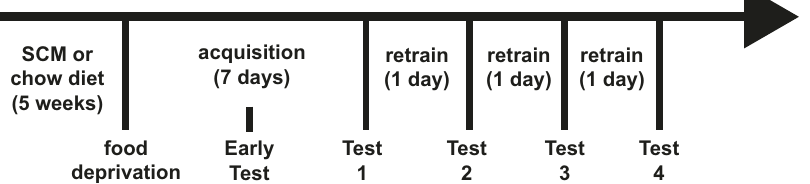
Fig. 1 Timeline for Experiment 1. Rats received 5 weeks of SCM or diet followed by instrumental training and four tests to evaluate sensitivity to outcome devaluation under drug and control